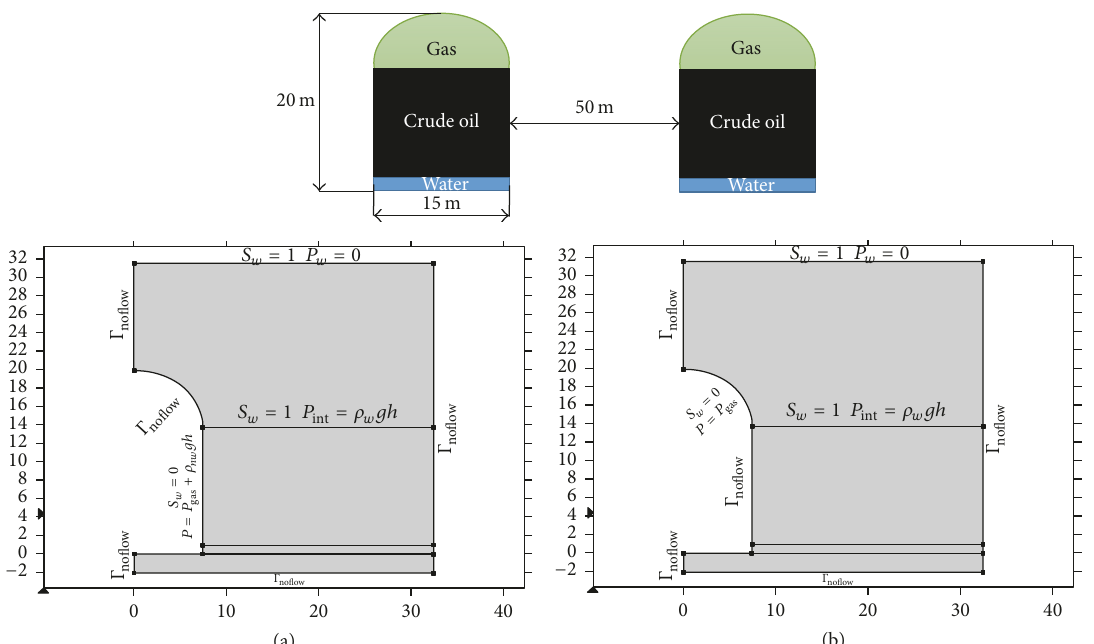
Figure 3: Scheme of the caverns dimensions and initial and boundary conditions for the numerical modelling of oil (a) and gas (b) seepage.